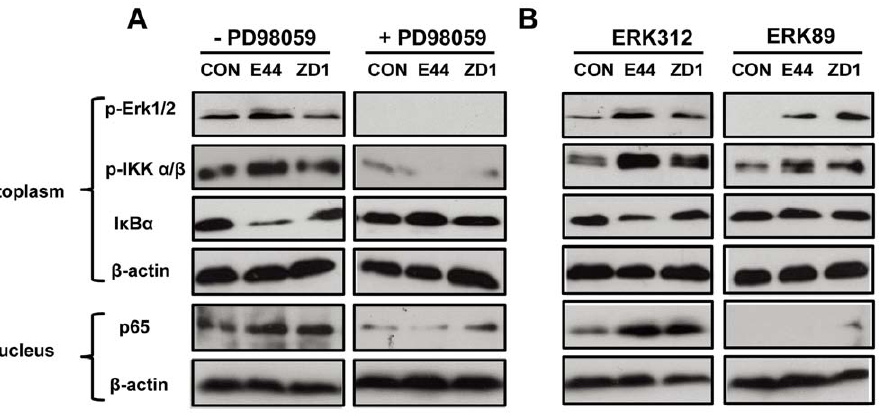
Figure 2. Inhibition of IbeA + E.coli -induced IKK phosphorylation and NF- k B activation by MEK/ERK inhibitors. ( A ) HBMECs were incubated with or without PD098059 (50 m M) for 60 min before stimulation with E44 or ZD1 (10 7 /ml). ( B ) HBMECs were incubated with or without ERK89 (vimentin-binding domain, 25 m g/ml) and ERK312 (control peptide, 25 m g/ml) for 60 min before infection with E44 or ZD1 (10 7 /ml). In both ( A ) and ( B ), ERK1/2 phosphorylation (p-Erk1/2), IKK a / b phosphorylation (p-IKK a / b ) and I k B a degradation were examined in cytoplasmic fractions after 30 min of stimulation with E. coli K1 strains. NF- k B (p65) translocation to the nucleus was examined in nuclear fractions after 2 h of infection with E. coli K1 strains. b -actin in both fractions was detected as internal loading controls. CON, control without bacterial